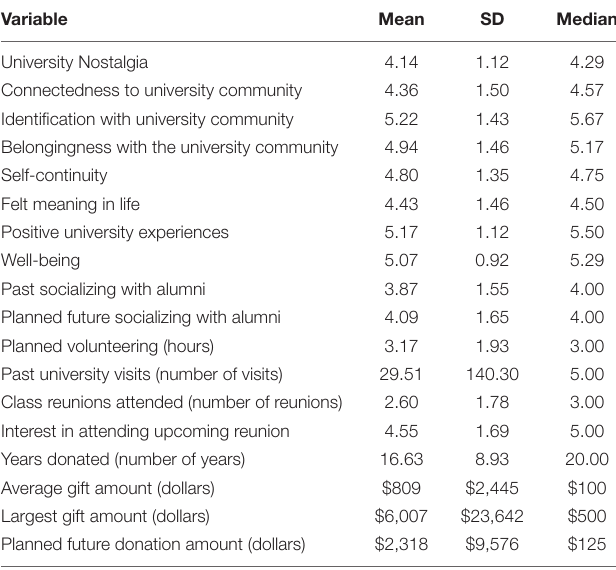
TABLE 4 | Means, standard deviation, and median of study 2